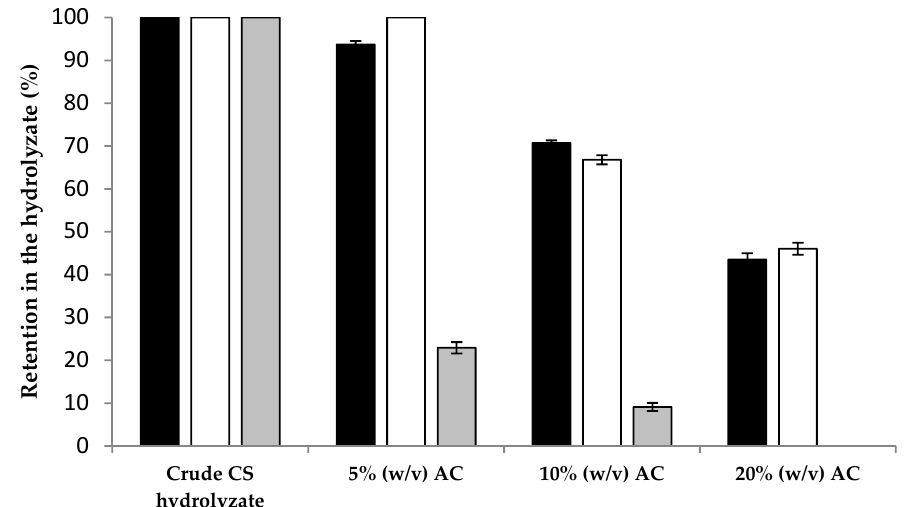
Figure 1. Retention of sugars and phenolic compounds in the CS hydrolyzate, before and after detoxification with AC at 5, 10 and 20% ( w / v ). Standard deviation ( n = 3) is indicated by the error bars (glucose, black; xylose, white; total phenols, grey).